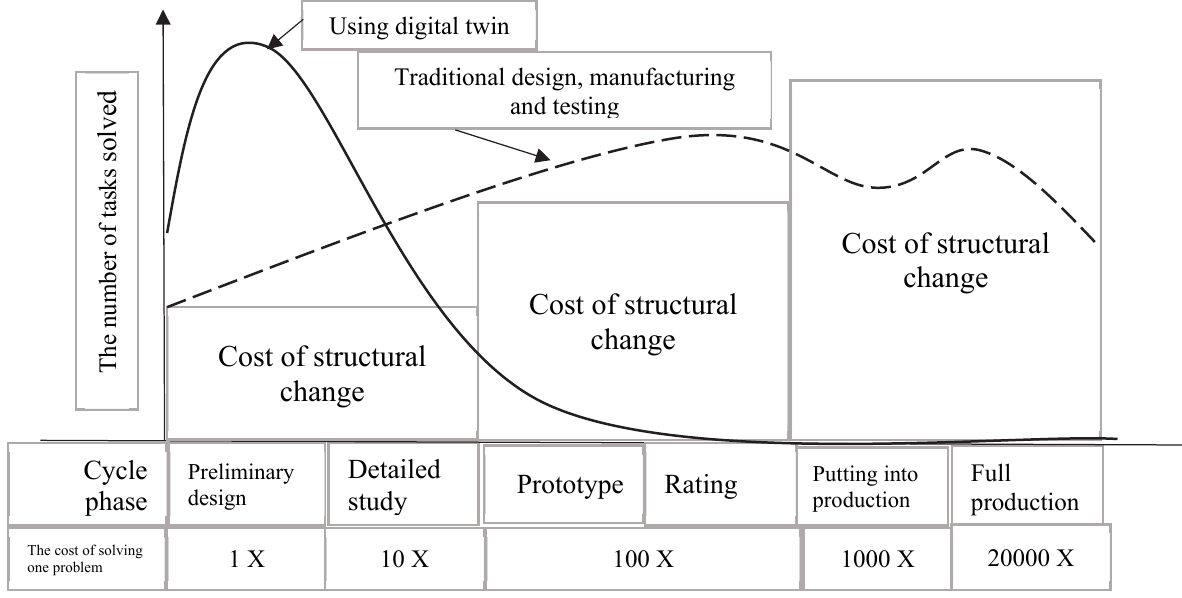
Fig. 3. Cost of product change using a digital